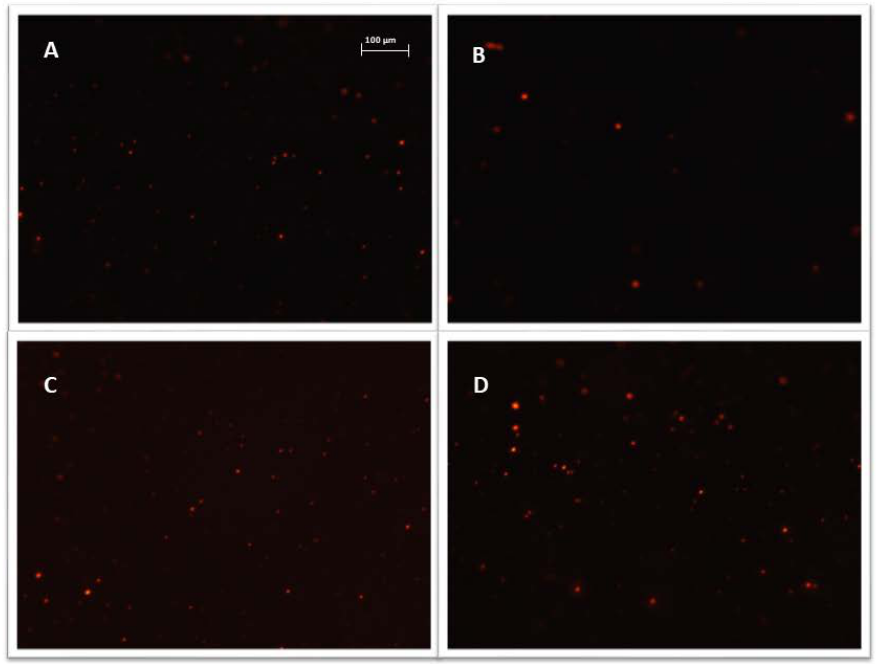
Figure 5. Representative images, exosomes (visible as red vesicles) stained with Vybrant ™ CM-Dil dye and purified on exosome spin columns (MW 3000), exosomes isolated from: ( A ) cisplatin treated A2780 cells; ( B ) α -mangostin treated TOV-21G cells; ( C ) cisplatin treated SKOV-3 cells; ( D ) untreated SKOV-3 cells. Nikon Eclipse Ti, magnification 100. ×